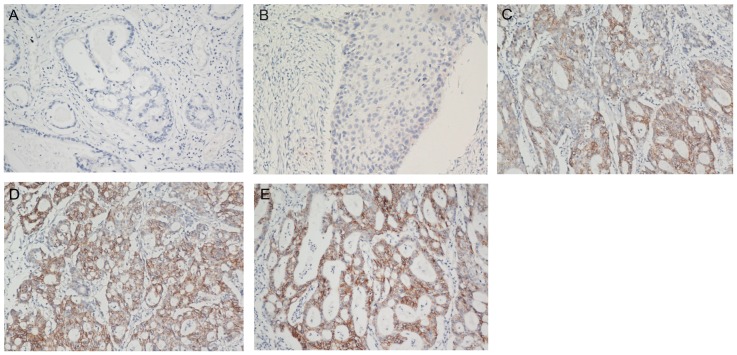
CDH17 expression in gastric carcinoma tumor samples.IHC staining in gastric carcinoma tissue (original magnification ×200). A: Negative, B: Weak, C: Positive(+), D: Positive(2+), E: Positive(3+).